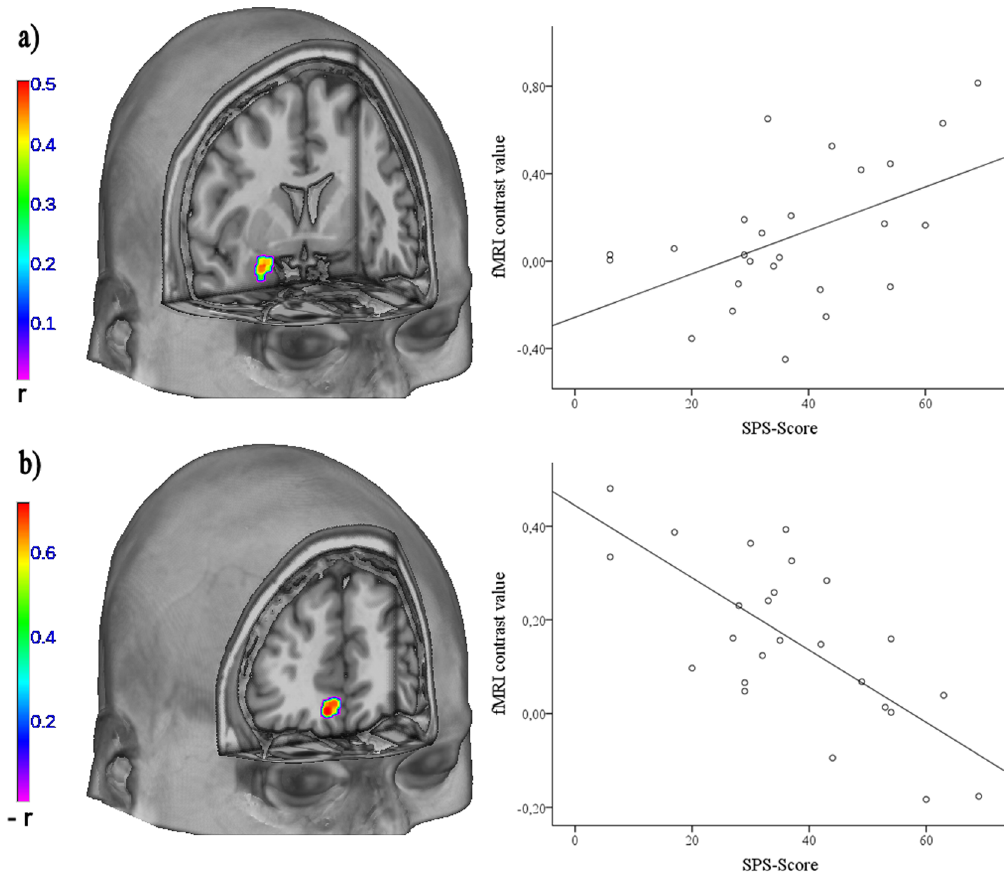
Figure 2. Correlations with disorder severity. a ) Left: Association of the patients’ SPS-scores with right amygdala responsiveness to SP-related versus negative words, rendered on an anatomical template in MNI-space. Color bar, correlation coefficient r . Right: Scatter plot depicting the positive correlation of the mean cluster activation values (left panel) and the SPS-scores. b ) Left: Association of the patients’ SPS-scores and the functional connectivity between the left amygdala and the right BA 10 and 11, rendered on an anatomical template in MNI-space. Color bar, correlation coefficient 2 r . Right: Scatter plot depicting the negative correlation of the mean cluster activation values (left panel) and the SPS-scores.